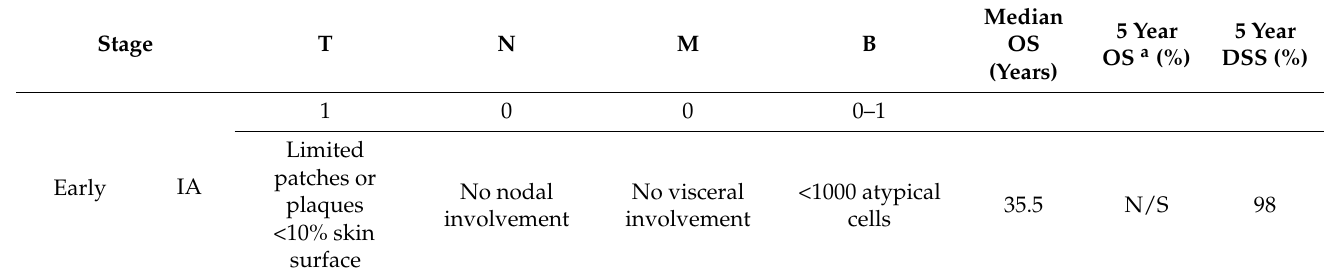
Table 1. International Society of Cutaneous Lymphomas (ISCL)/European Organization for Research and Treatment of Cancer (EORTC) revision to the staging of mycosis fungoides (MF) and S é zary syndrome (SS). T: skin, N: lymph node, M: viscera, B: blood, OS: overall survival, DSS: disease-free survival. N/S: not specified. a Data extracted from [18].